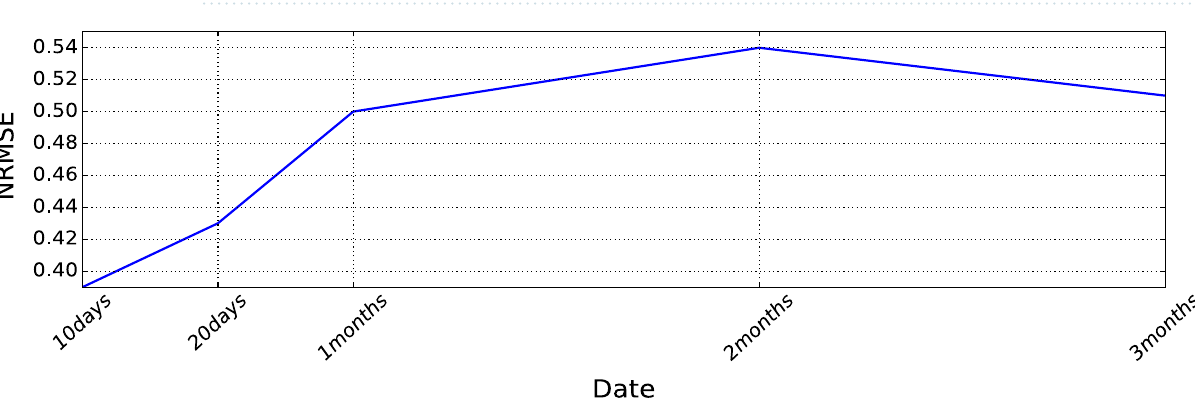
Figure 11. An example of inflow forecasting with CVD-LSTM and LSTM compared with true values for scenario 4.